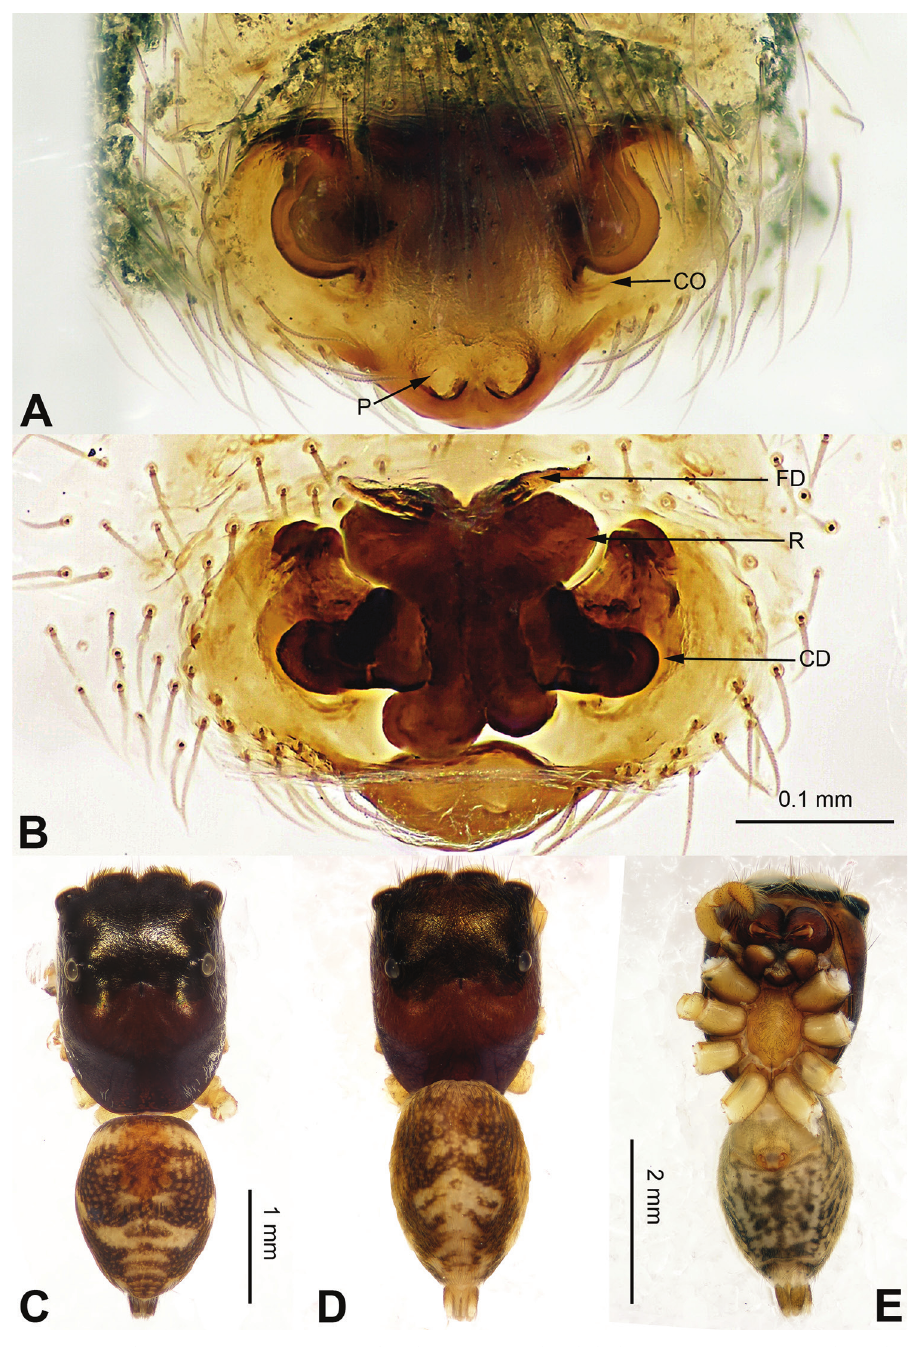
Figure 14. Chinattus wengnanensis sp. n., female paratype and male holotype. A epigyne, ventral B vulva, dorsal C male habitus, dorsal D female habitus, dorsal E female habitus, ventral. Scale bars equal for A and B ; equal for D and E